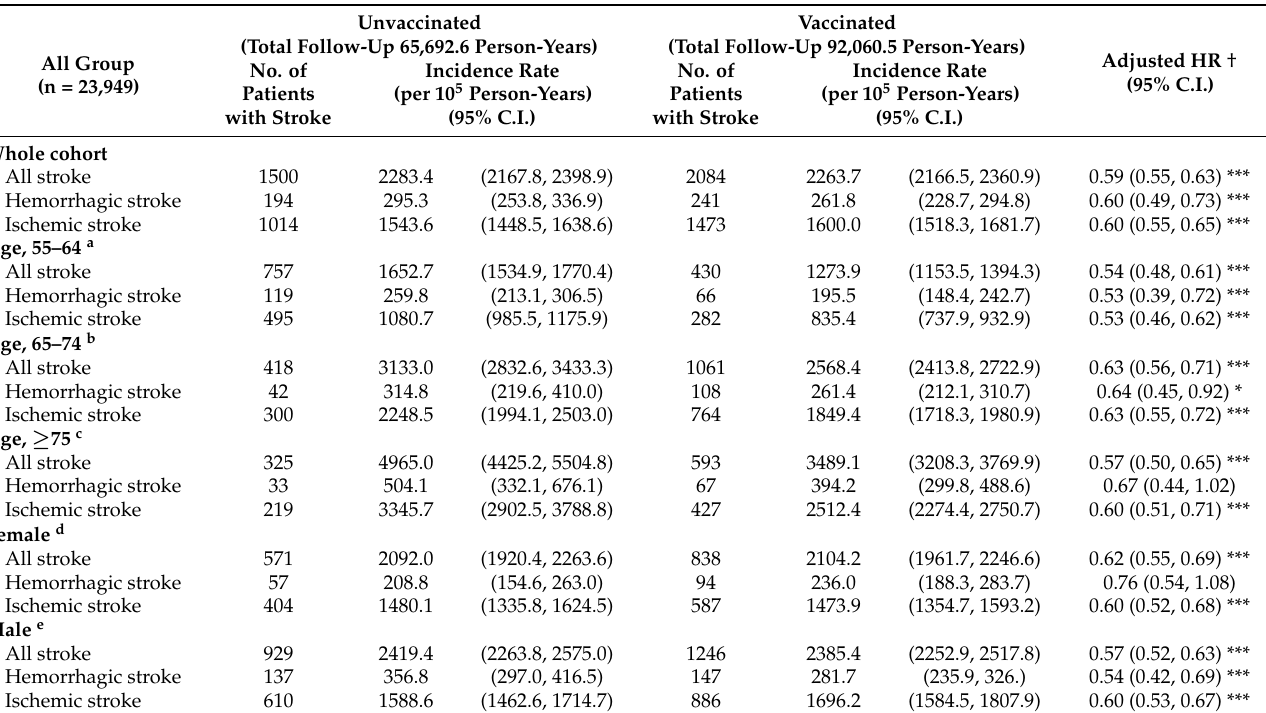
Table 2. Risk of all stroke among the unvaccinated and vaccinated groups in study cohort.